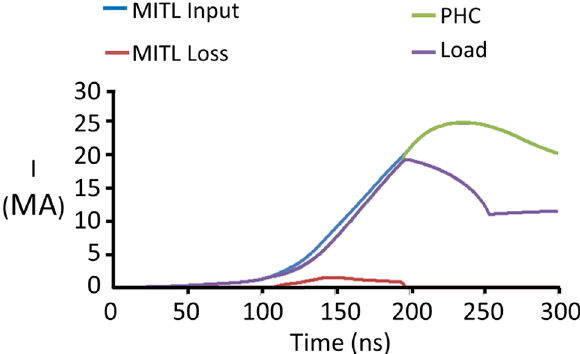
FIG. 11. The effect of the Z loss resistance immediately Flow after the PHC and beginning at 190 ns for the very stressing surrogate load is illustrated with Jennings ’ s model of the current loss. The losses are shown as the difference between the PHC current and the load current. The losses in the MITL before the PHC are shown as MITL loss, which goes to almost zero in the simulation after the Z current loss Flow